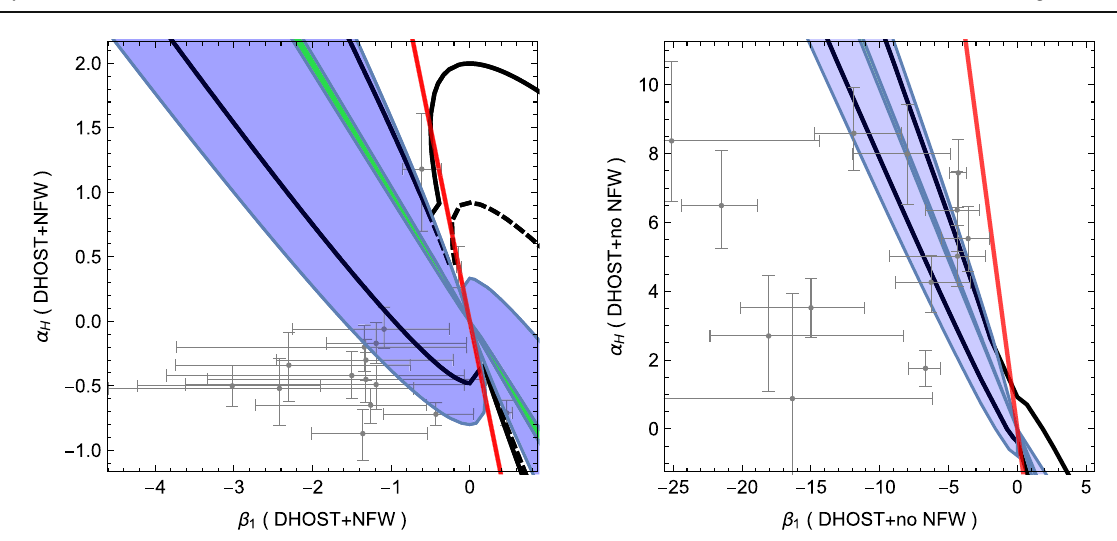
constraints from this work. In all cases we assume a constant stellar anisotropy profile. In both panels blue regions are derived from stellar physics considerations [20]; the red region is derived from 2 σ limits on γ σ constraints [114] 0 from the Hulse–Taylor pulsar; helioseismology 2 are shown as green regions. Single constraints from CLASH clusters as obtained by [18] are shown as grey